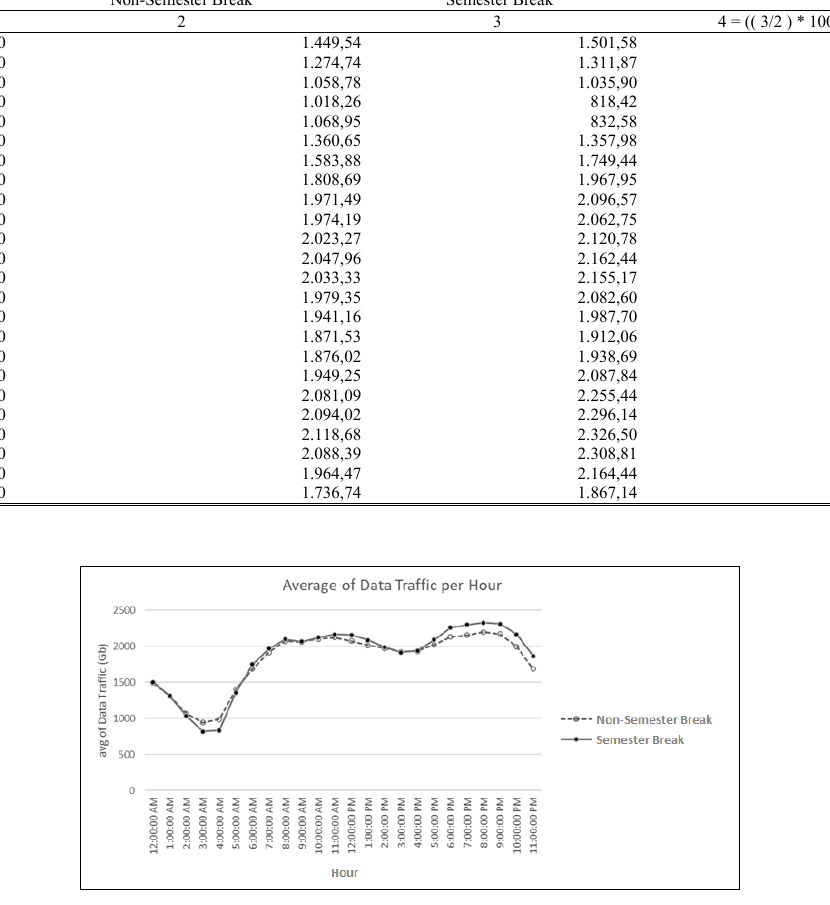
Fig. 10 Trends and patterns of the Internet use between semester break and non-semester